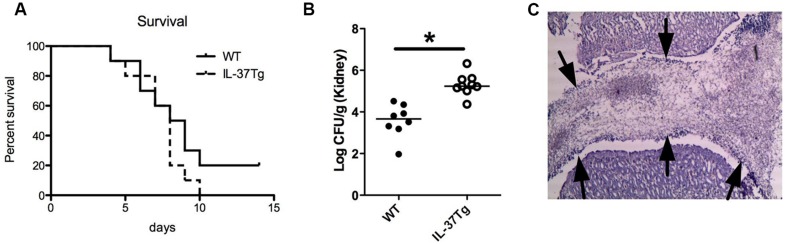
hIL-37Tg mice are highly susceptible to disseminated C. albicans infection. (A) Survival of hIL-37Tg mice and WT mice intravenously infected with live C. albicans yeast (1 × 10e6 CFU). (B) hIL-37Tg mice and WT mice were infected i.v. with C. albicans blastoconidia (5 × 10e5 CFU/mouse). Subgroups of animals (a total of nine mice/group/time point, in two separate experiments) were killed on day 7 of infection, and fungal outgrowth was assessed in the kidneys. (C) Histology representing the accumulation of C. albicans hyphae (fungal ball) in the pyelum of hIL-37Tg mice. Arrows point to the edge of the fungal ball present in the pyelum of the kidney (A). Survival was assessed daily for 2 weeks. (n = 10/group; B) Mann–Whitney U-test, *p< 0.05.